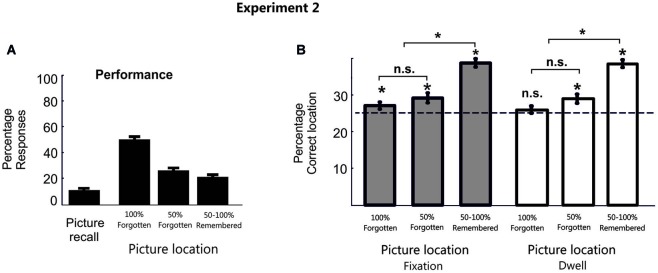
Behavioral data in Experiment 2. (A) Percentage behavioral responses averaged across participants for Experiment 2. (B) Bar plots represent the proportion of fixation and dwell time in the correct picture location averaged across participants in Experiment 2. Error bars denote Standard Error of the Mean. * p < 0.05; “n.s.” denotes p > 0.05.